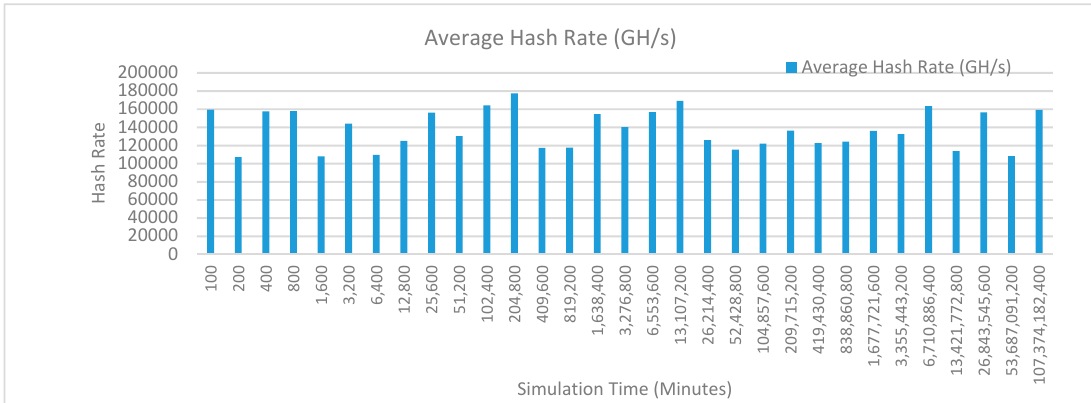
Figure 12. Average hash rate analysis (with IoT and edge).